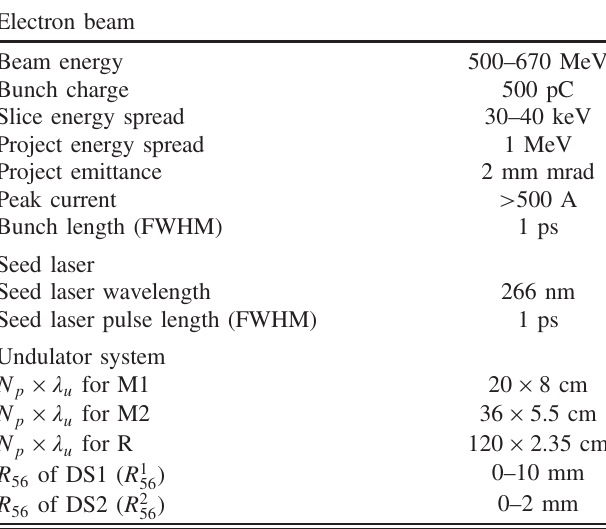
TABLE I. Main parameters of the EEHG experiment. Electron beam